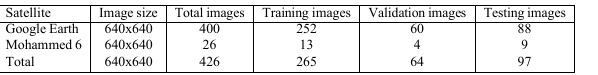
Table 1: Spatial data used in the